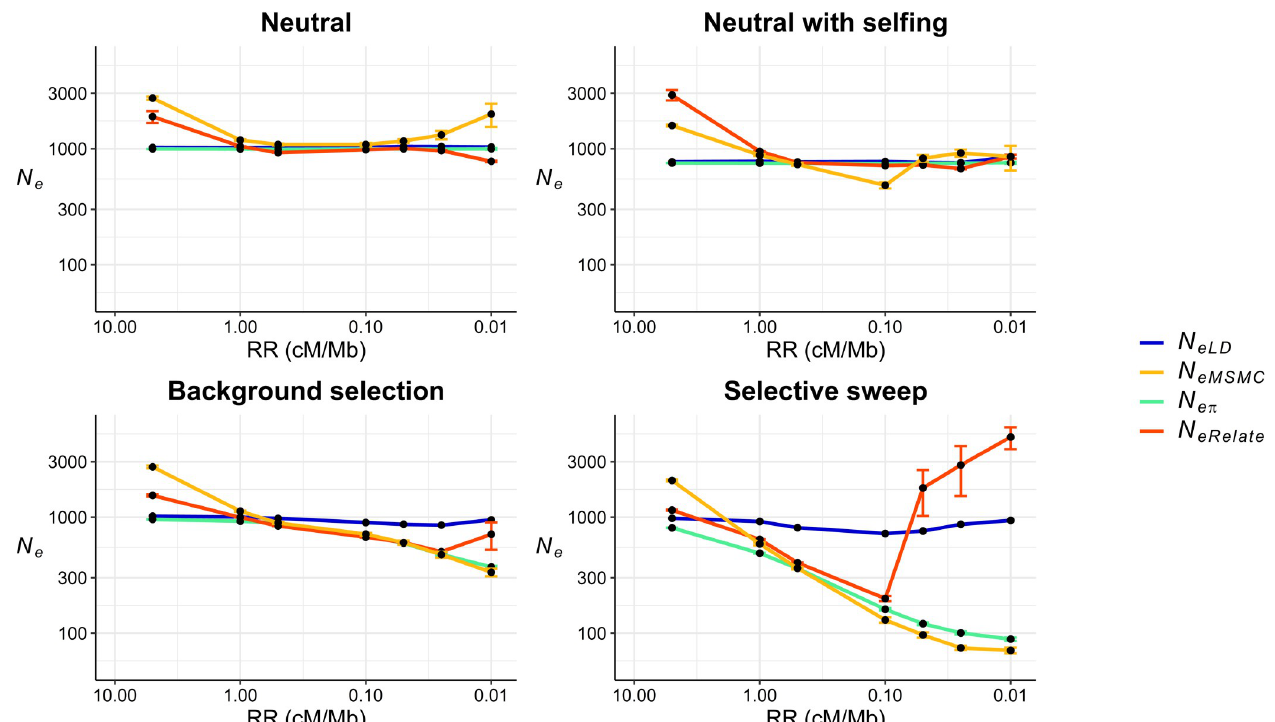
Fig 1. Estimates of effective population size from linkage disequilibrium ( N eLD , sample size of n = 100 individuals), Relate ( N eRelate , n = 100), MSMC ( N , n = 4), and from nucleotide diversity ( π ), this latter calculated as N = π /(4 μ ), where μ is the nucleotide mutation rate, for scenarios with eMSMC eπ different recombination rates ( RR in cM/Mb) uniform across the genome. Simulations assume a fixed population size of N = 1,000 individuals under neutrality (random mating or partial self-fertilization with a frequency of 50% selfed progeny), background selection and selective sweeps (both for random mating populations), with constant mutation rate μ = 10 − 8 per base per generation. Estimates were obtained including windows of recombination rate between pairs of SNPs ranging from c = 0.0025 to 0.0250 for N eLD and averaging historical estimates of N e between generations 150 to 350 for N eRelate and N eMSMC . Error bars represent one standard error above and below the mean of the simulation replicates. N eLD estimates were obtained pooling all replicates to speed up computation. All simulations were run for up to 100 replicates.